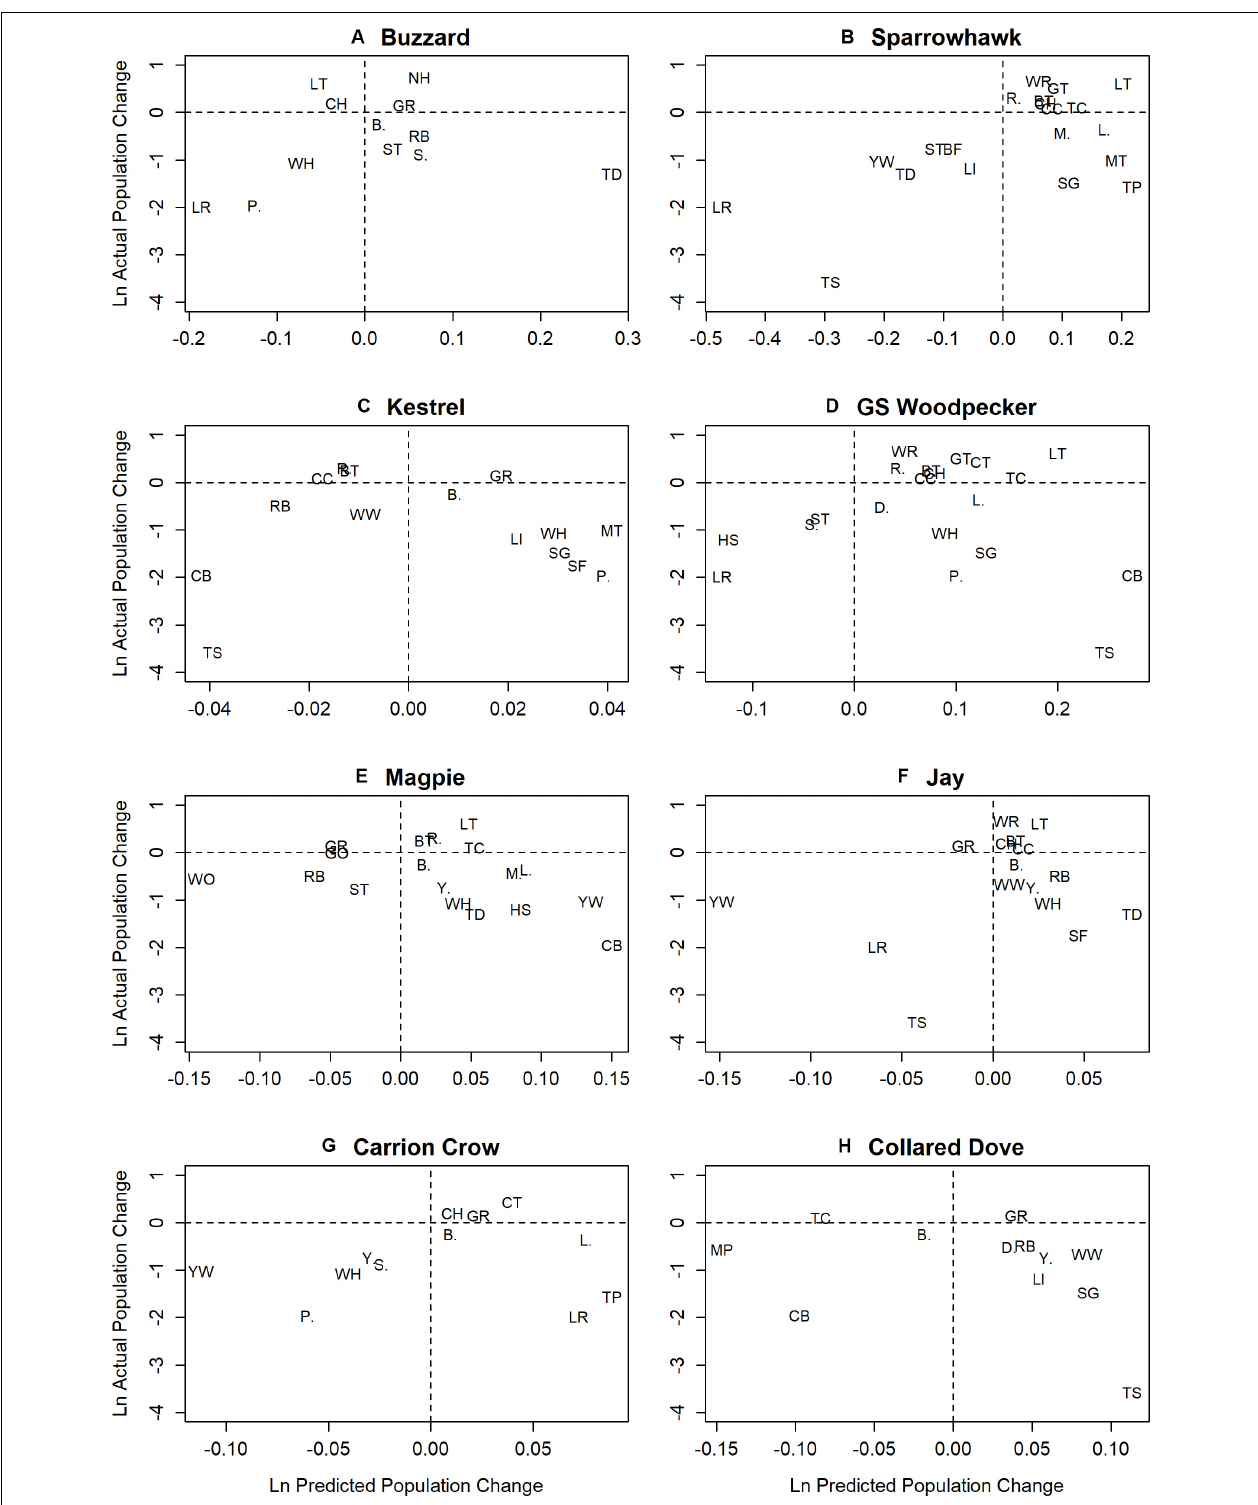
FIGURE 4 | Plots of predicted ln prey population change across all census sites (ln R prey ) against ln actual population change for prey species with significant predator effects. Parts (A–H) show ln predicted prey population change from 1967–2000, as estimated from change in mean site occupation by individual predators and their prey-specific effect estimates, plotted against ln actual prey population change for the same period, except for prey species in which population estimates start later than 1967, i.e. House Sparrow (1976) and Wood Warbler (1994) (Woodward et al., 2018).